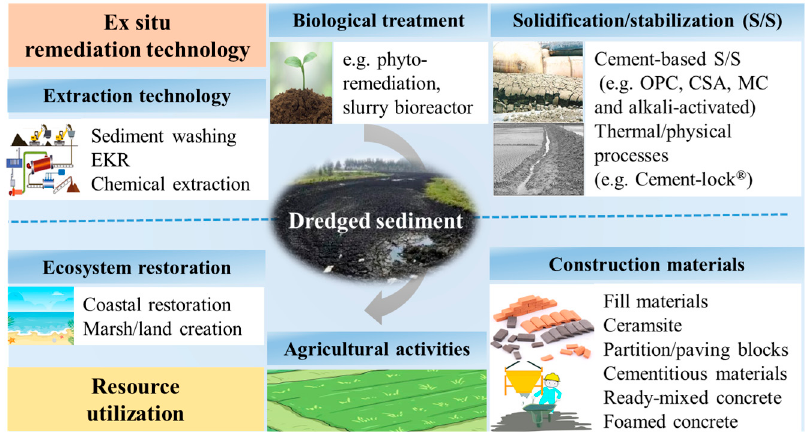
Figure 1. Ex situ remediation technology and resource utilization for heavy metal contaminated sediment.